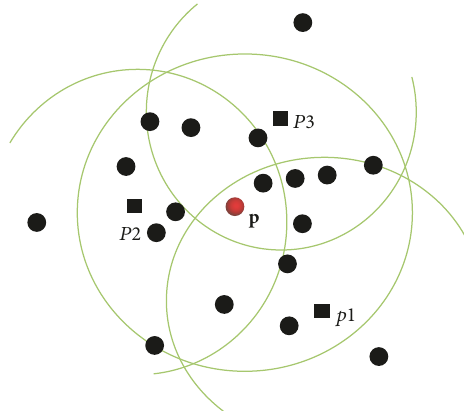
Figure 1: Seed points and 𝑘 neighborhood in two-dimensional space; 𝑝 is the core point and 𝑝 1, 𝑝 2, and 𝑝 3 are the seed